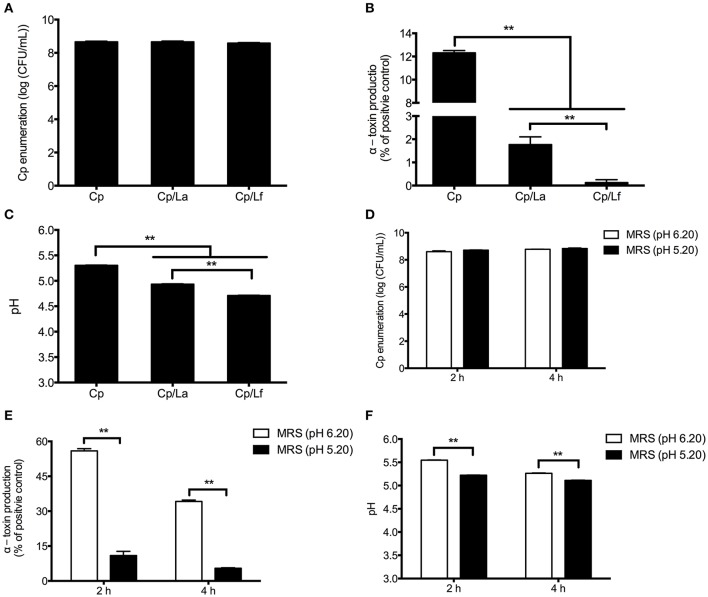
The effect of lactobacilli and pH on the number and α-toxin production of C. perfringens as well as pH of cultures. C. perfringens enumeration (A), α-toxin production (B) and pH values (C) were determined after 4-h co-culture of C. perfringens and lactobacilli. C. perfringens was grown in the MRS broth with normal (6.20) and lower (5.20) pHs for 2 and 4 h. The CFU of C. perfringens
(D), α-toxin secretion (E) and pH (F) were measured at each time point. Data are presented as mean ± standard error (n = 3). **P < 0.01. La, L. acidophilus; Lf, L. fermentum; Cp, C. perfringens; MRS, Mann-Rogosa-Sharpe medium.